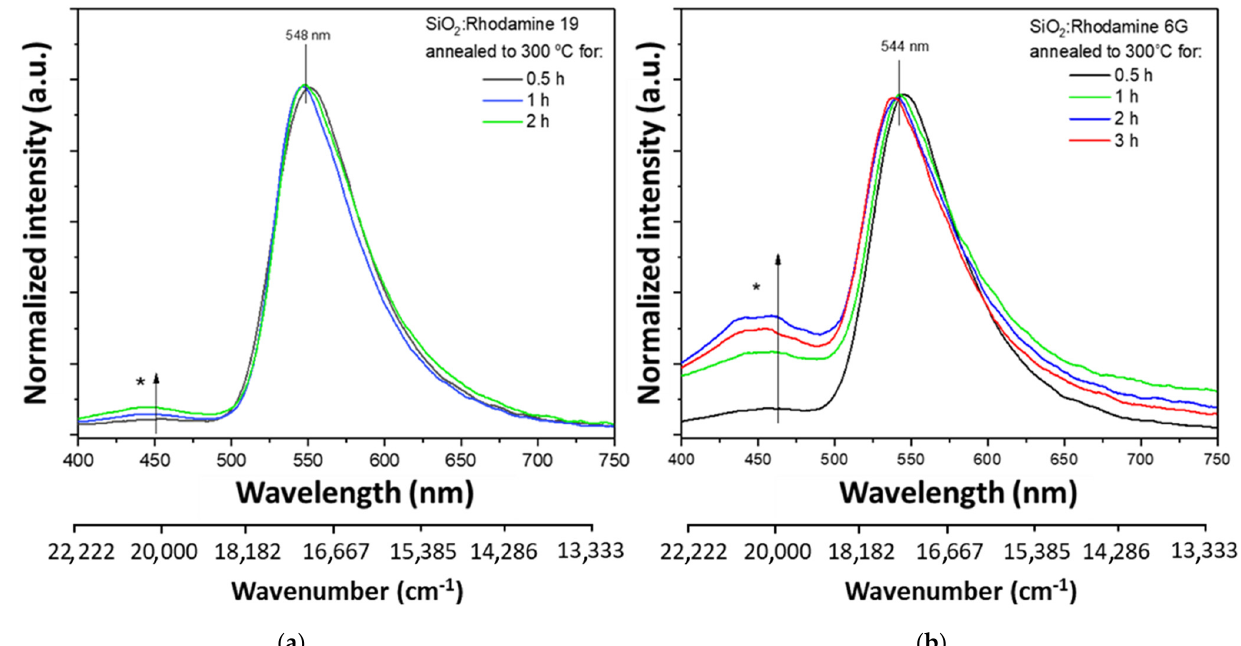
Figure 3. Normalized emission spectra for gels annealed at 300 ◦ C for different time periods, λ ex = 280 nm. Marked with an asterisk − an additional band associated with emission from silica matrix. As the annealing time is lengthened, the ratio of the dye-derived band to the silica changes in favor of silica: ( a ) SiO 2 : Rhodamine 19; ( b ) SiO 2 : Rhodamine 6G. However, the maxima derived from organic dyes do not shift in either case